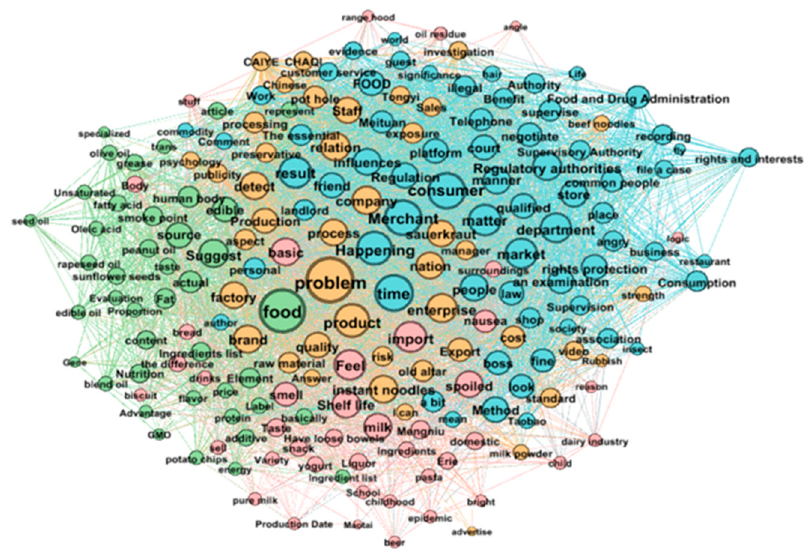
Figure 7. Semantic community structure. Table 12. Semantic community division of the topic of food